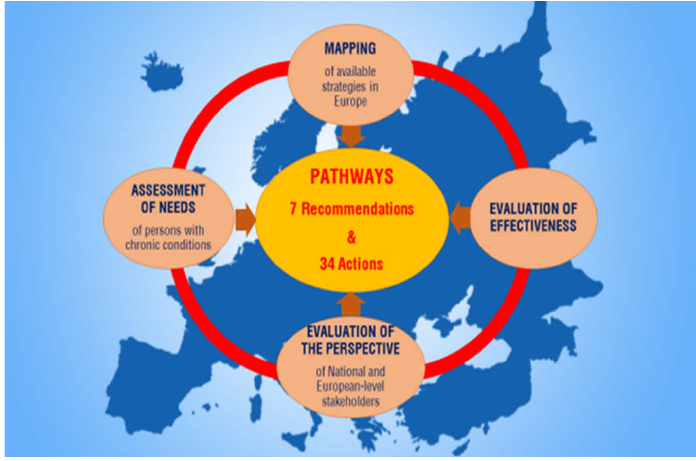
Figure 1. PATHWAYS focused on the situation of PERSONS WITH CHRONIC CONDITIONS and EMPLOYMENT and had four research streams. EMPLOYMENT and had four research